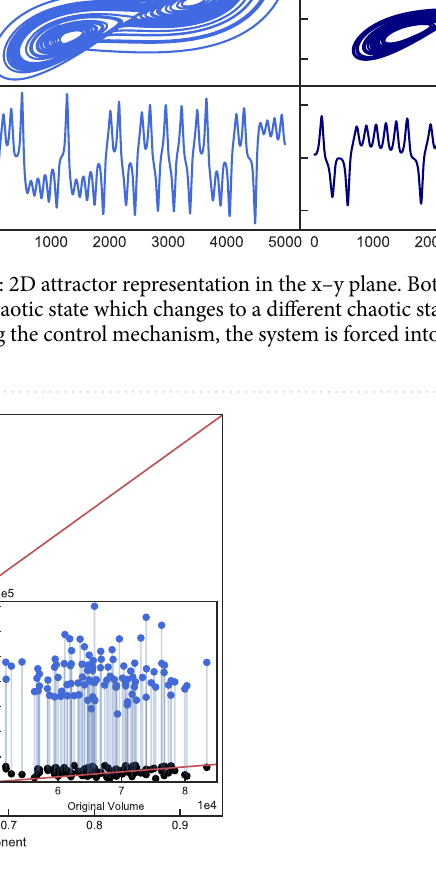
Figure 4. Chaotic to chaotic control ( ρ changed). Values on the x-axis denote the largest Lyapunov exponent (cid:31) max of the original system state before parameter change for N = 100 random realizations. Y-axis reflects the values for (cid:31) max after parameters changed from ρ = 28 to ρ = 50 . The blue dots correspond to the uncontrolled systems, while the black dots represent the controlled systems. Inlay plot shows the same for the volume of the